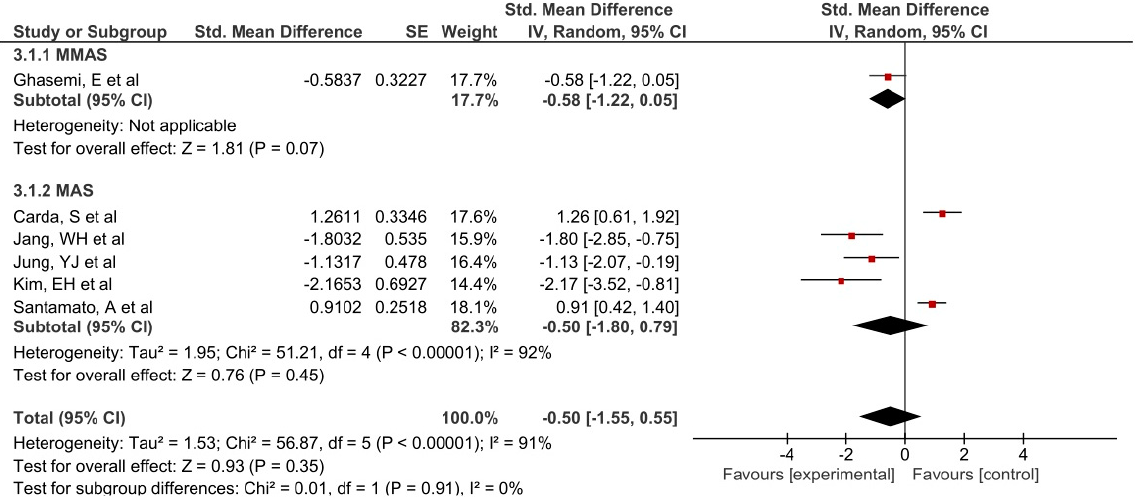
Figure 4. Forest plot of the comparison of the difference between the subgroups in MAS/MMAS. Figure 5. Forest plot of the comparison of the difference between the groups in ROM.